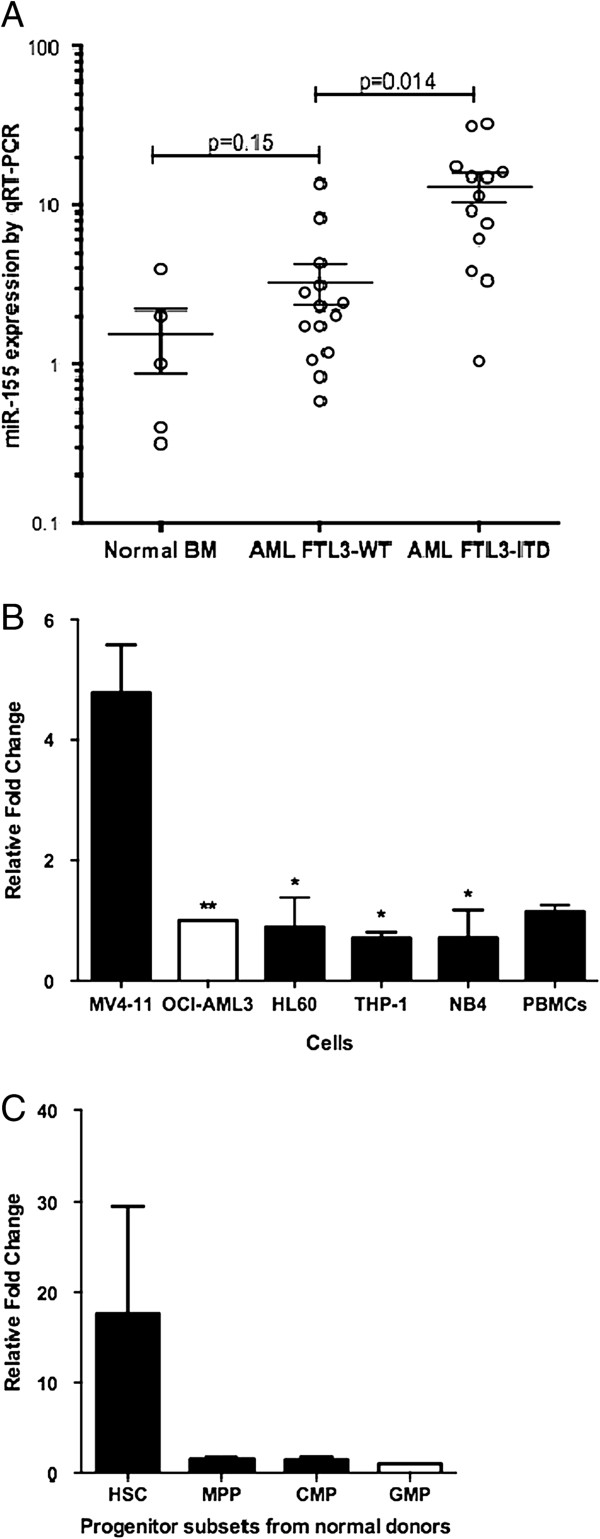
miR-155 expression in AML samples and normal haematopoietic cells. (A) miR-155 expression levels by qRT-PCR in normal bone marrow (5 samples) and AML samples with FLT3-ITD (13 samples) or wildtype (14 samples), values are normalized to the mean of the normal bone marrow samples (B) miR-155 expression in selected AML cell lines and PBMCs, presented as mean fold change + SEM relative to OCI-AML3 (baseline set at 1, white bar). Unpaired Two Tailed T-Test compared to expression levels in MV4-11 cells, *p < 0.05, **p < 0.001. n = 3-5 (C) miR-155 expression levels of haematopoietic progenitor subsets isolated from four normal mobilized peripheral blood donors, presented as mean + SEM relative to GMP. No statistical difference detected between groups using Paired t-test. HSC- haematopoietic stem cell; MPP- multipotent progenitor; CMP- common myeloid progenitor; GMP- granulocyte monocyte progenitor.